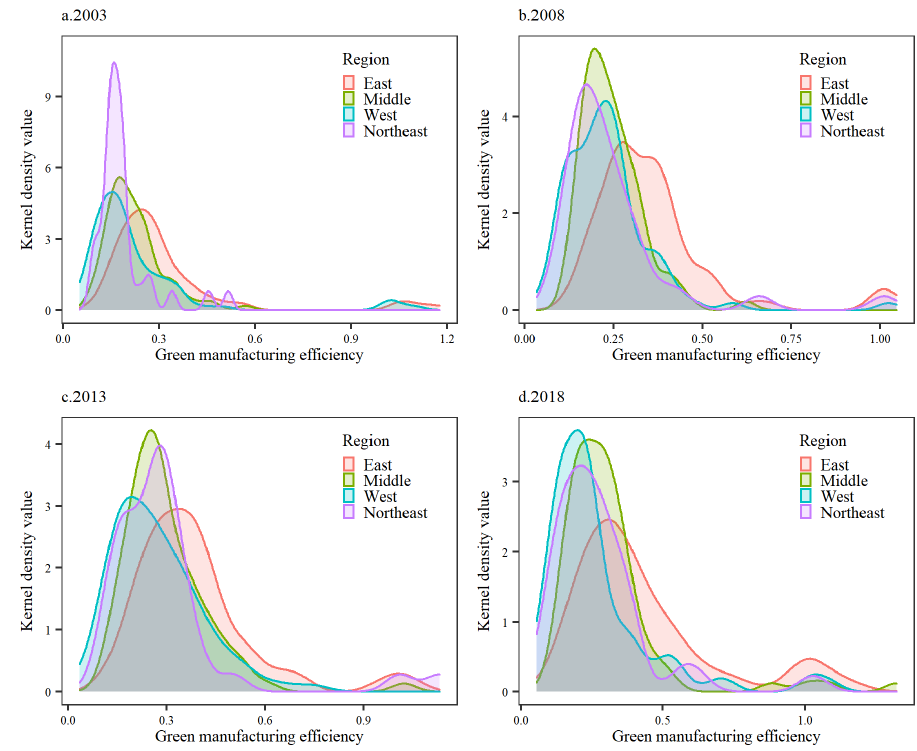
Figure 3. Kernel Density of Green Manufacturing Efficiency in China by Region, 2003 to 2018.